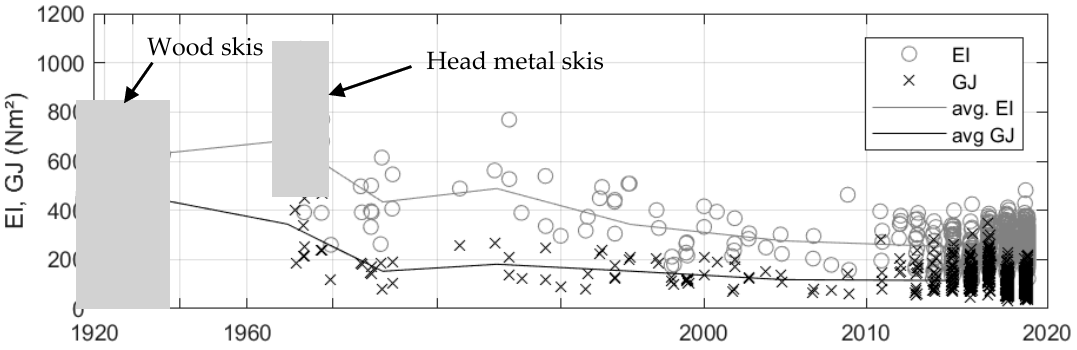
Figure 7. Length-averaged bending and torsional stiffnesses vs. model year. The solid lines, ‘avg. EI’ and ‘avg. GJ’ are the mean values averaged over each whole decade.